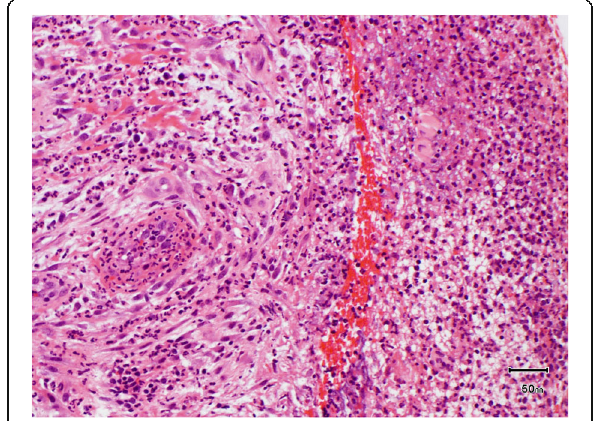
Fig. 4 Biopsy floor of the mouth (AE in A1, × 20 magnification)